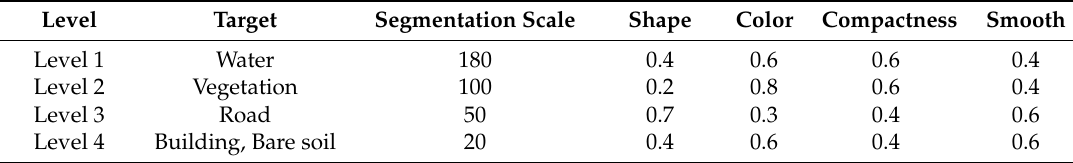
Table 2. Parameters related to segmentation.